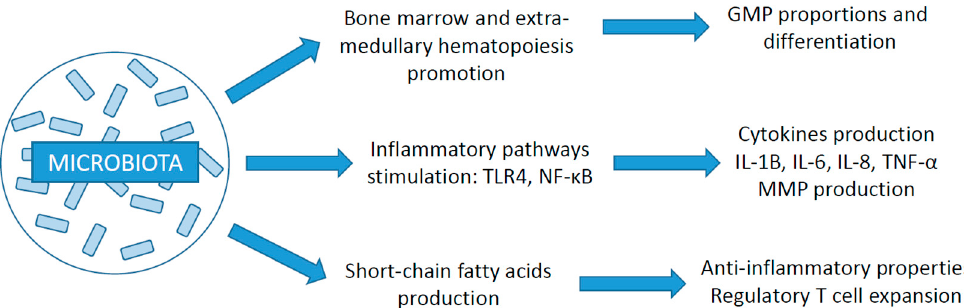
Figure 1. Schematic diagram summarizing the relation between the microbiota and the immune system (GMP: granulocyte and/or monocyte progenitor; TLR4: Toll-like receptor 4; NF- κ B: nuclear factor kappa B; IL: interleukin; TNF: tumor necrosis factor; MMP: matrix metalloproteinases) [15–17].